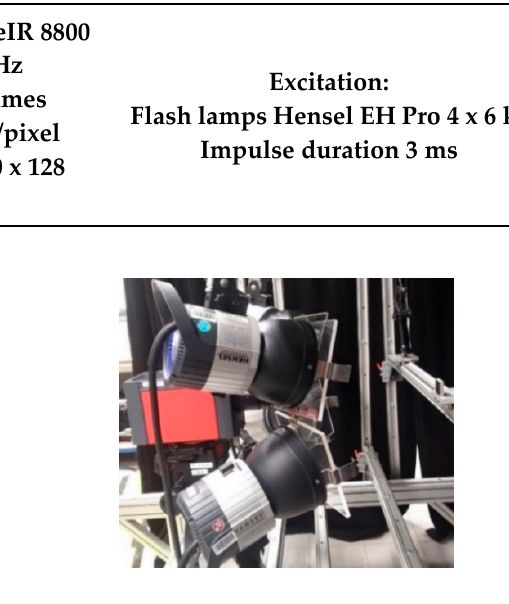
Figure 1 . Setup for pulsed thermography with four flash lamps. Table 2. Thermographic parameters and setup distances for stepped thermography .